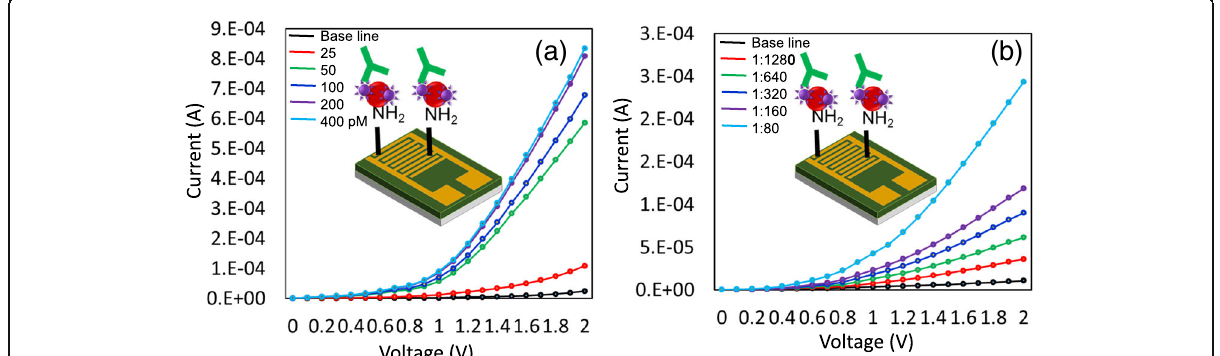
Fig. 7 a Limit of detection of FIX-conjugated GNP on IDE sensing surface. FIX was titrated from 25 to 400 pM. The limit of detection was found to be 25 pM. b Detection of FIX in human serum on the IDE sensing surface. Human serum was diluted from 1:80 to 1:1280. FIX was detected in human serum diluted